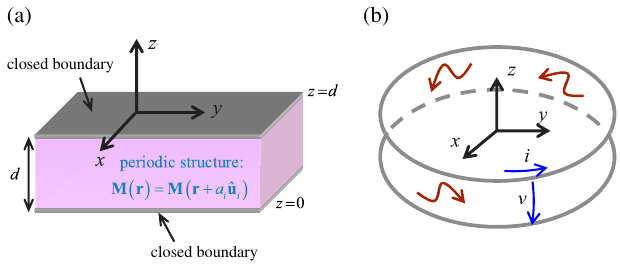
FIG. 1. (a) Representative geometry of the system under study. The bulk region is periodic along the x and y directions ˆ u [ M ð r Þ ¼ M ð r þ a , with a 1 ; a 2 the spatial periods along x i i Þ L 1 × L 2 and and y ]. The structure cross section has area A tot ¼ generally encompasses many elementary cells of the associated photonic crystal. The system is closed along z so that the energy is forced to flow along directions parallel to the xoy plane. In this study there are two cases of interest: (i) the fields satisfy opaque- type (e.g., perfectly electric conducting) boundary conditions at the lateral walls (not shown) and (ii) the fields satisfy periodic boundary conditions at the lateral walls. (b) For opaque-type lateral walls, the photonic insulator cavity is equivalent to a circular one-dimensional transmission